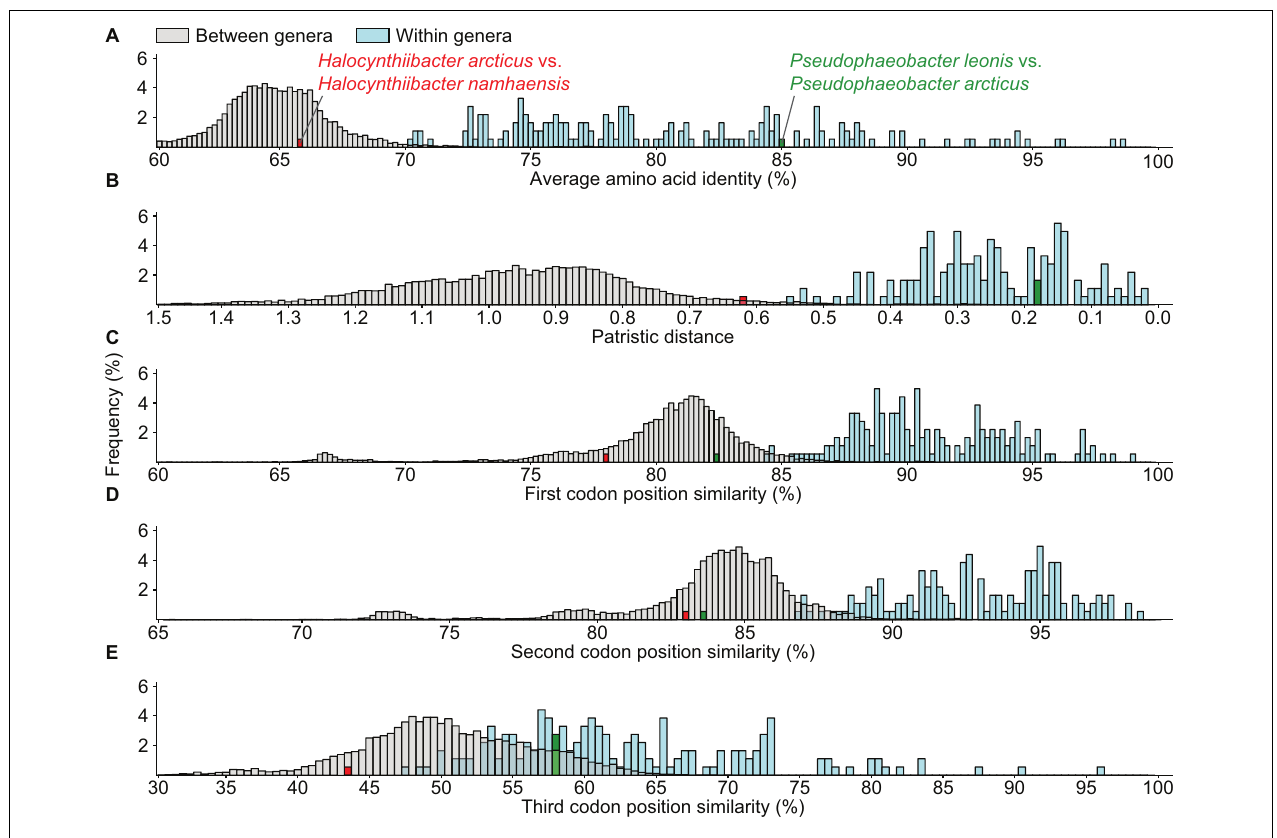
FIGURE 3 | Histogram of (A) average amino acid, (B) patristic distance, and (C–E) 1st, 2nd, and 3rd codon position similarities for all between (gray) or within (blue) recognized monophyletic genera. The distributions for within and between genera comparisons for all metrics are statistically significant ( p < 0.05) based on the Mann–Whitney U test. The red and the green bars represent two atypical within genus comparisons.